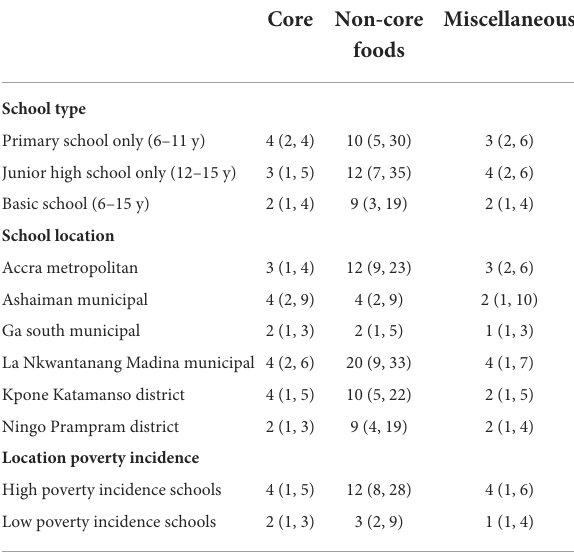
TABLE 4 Median (25-, 75-percentiles) number of food and beverage category advertised by school characteristics. Food category Core Non-core